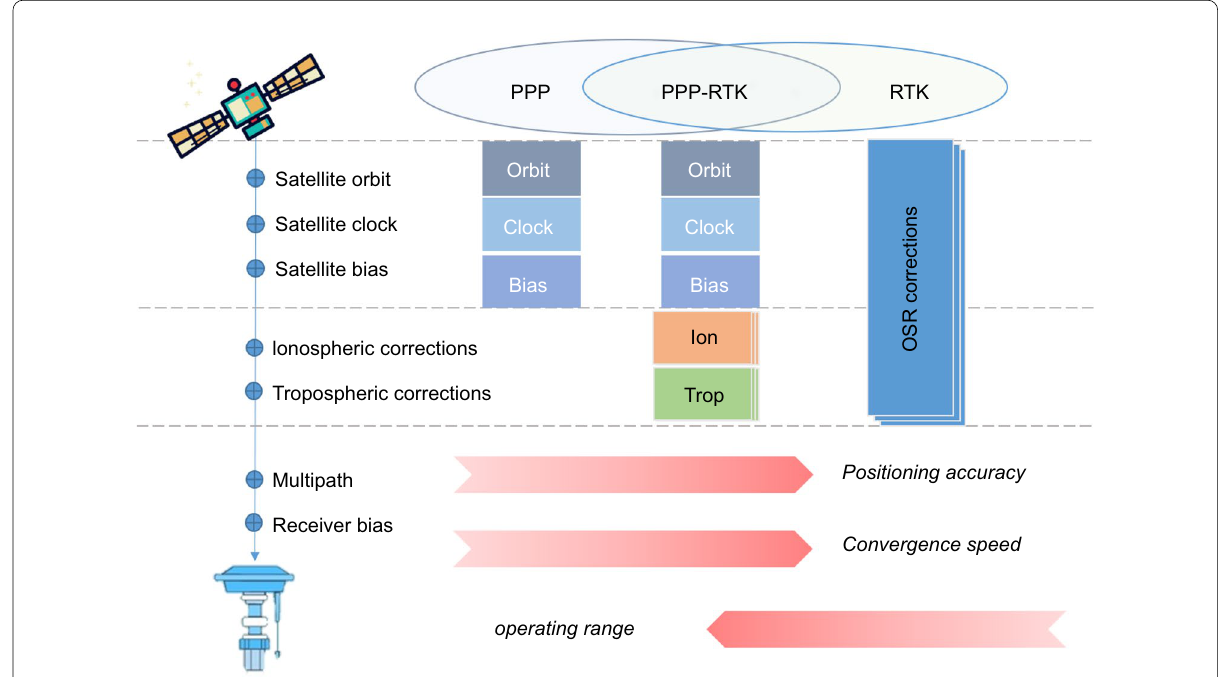
Fig. 1 Comparison of PPP, RTK, and